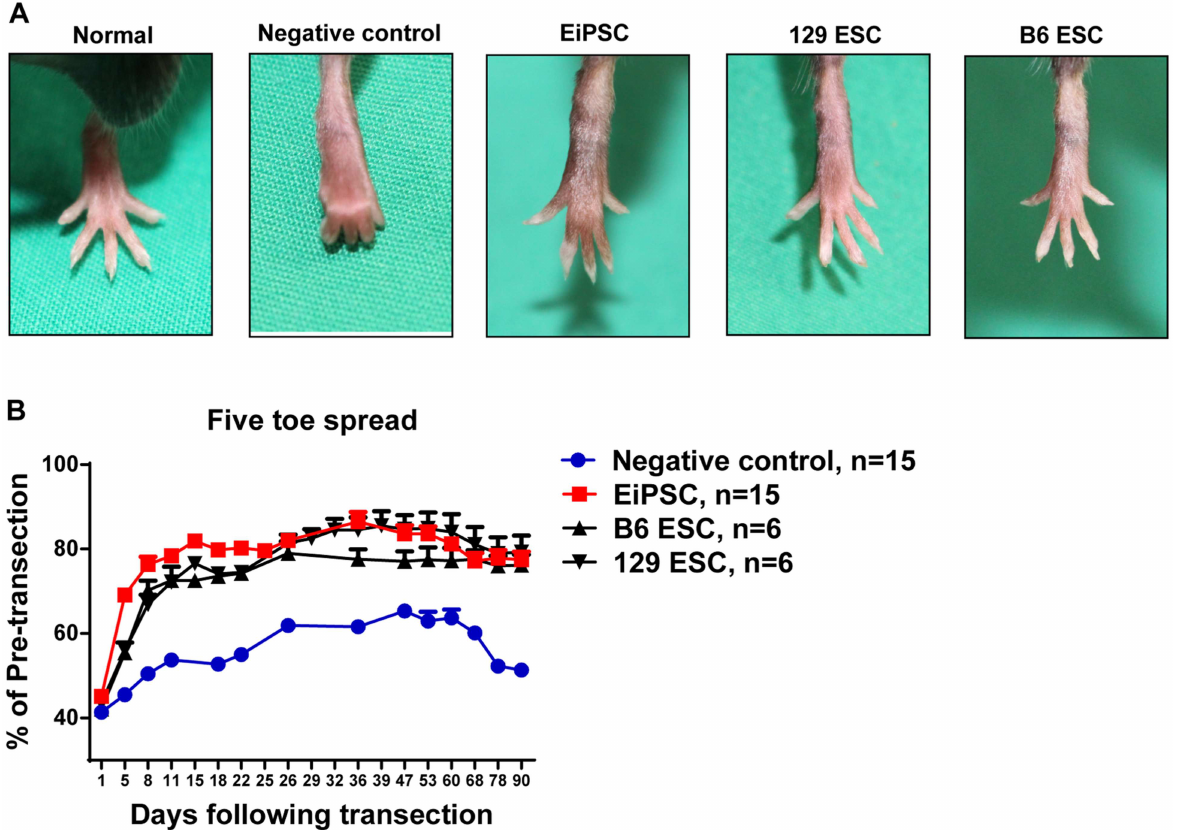
Fig 3. Functional recovery evaluated using five toe spread analysis. (A) Photographs of five toe spread at postoperative day 36 in five different groups of mice—normal (pre-transected), negative control (PBS only), EiPSC, 129 ESC and C57BL/6 (B6) group. (B) Cumulative graph of the four different groups expressed as a percentageof five toe spread recovery over pre-transection measurements postoperatively. The statistical data comparing EiPSC, 129 ESC and B6 ESC groups between negative control showed a mean ± SEMwhich was significant ( P value of < 0.0001, one-way ANOVA) at each time point.